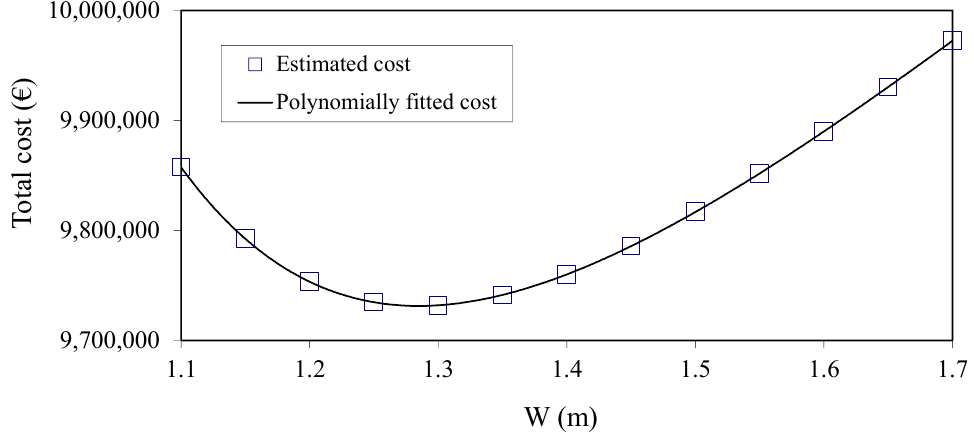
Figure 11. Total costs ( € ) as a function of the additional height of the crest element, W (m), when a third layer is added above the primary armor layer ( K D = 4.9).